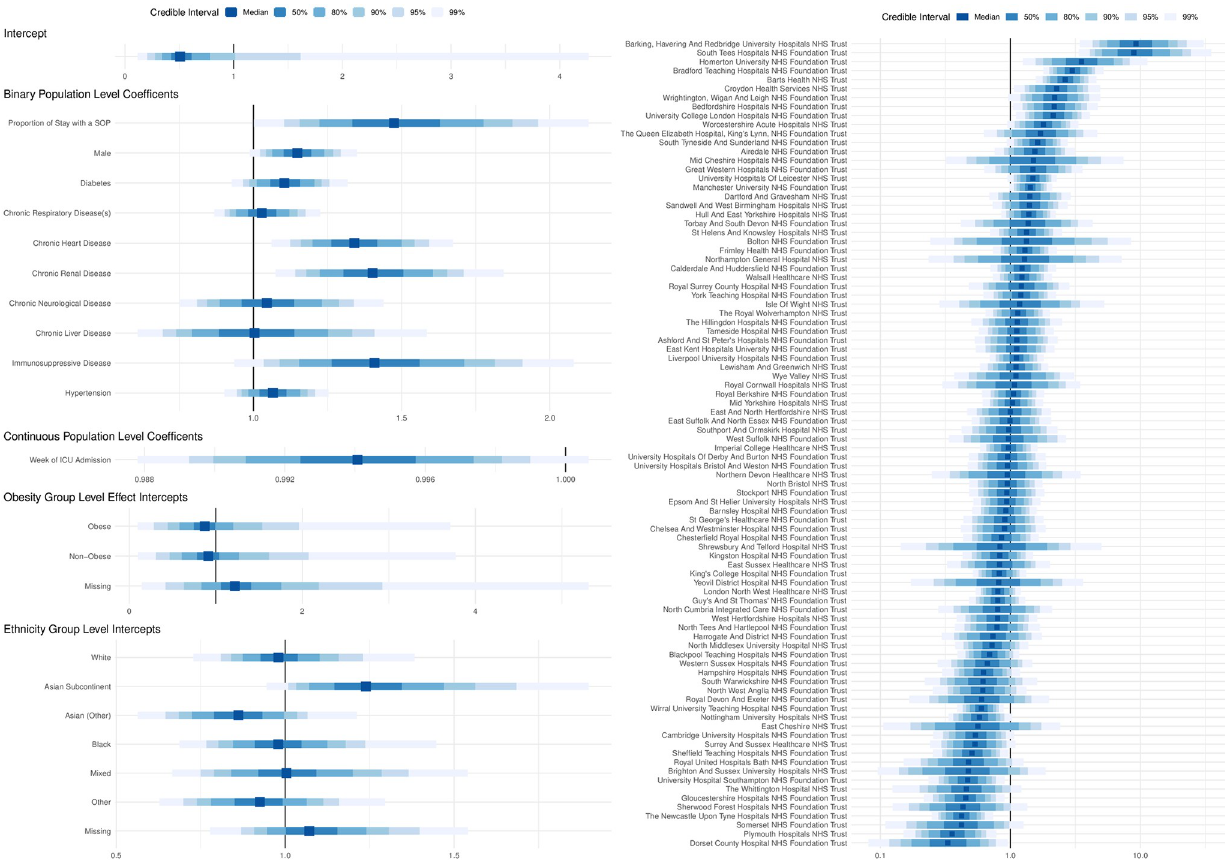
Fig 4. Forest plot of all co-variates in the final model in which the proportion of a patient’s stay during which the relevant trust was experiencing a serious operational problem was the exposure of interest. (Left) A forest plot of all the effect estimates and marginal posterior densities for each covariate in the final model in which the proportion of a patient’s stay during which the relevant trust was experiencing a serious operational problem was the exposure of interest. (Right) The marginal posterior densities (on a log odds scale) for the random effect for each trust (i.e. small group of hospitals that function as a single operational unit), in the aforementioned